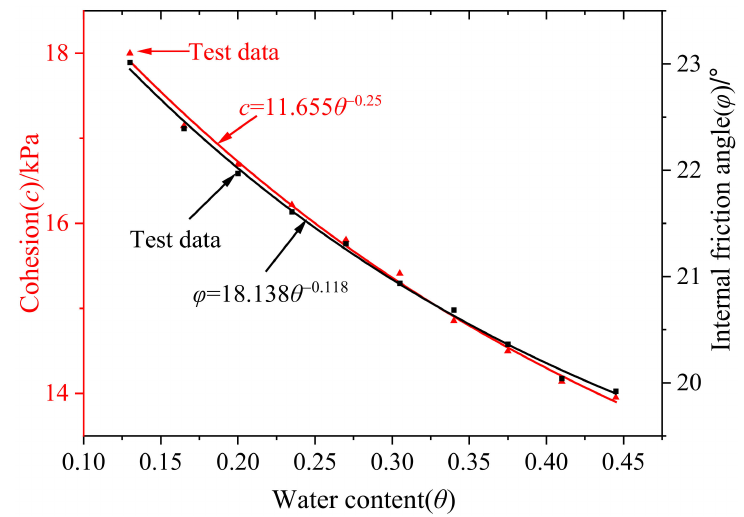
Figure 6. Cohesion and internal friction angle versus water